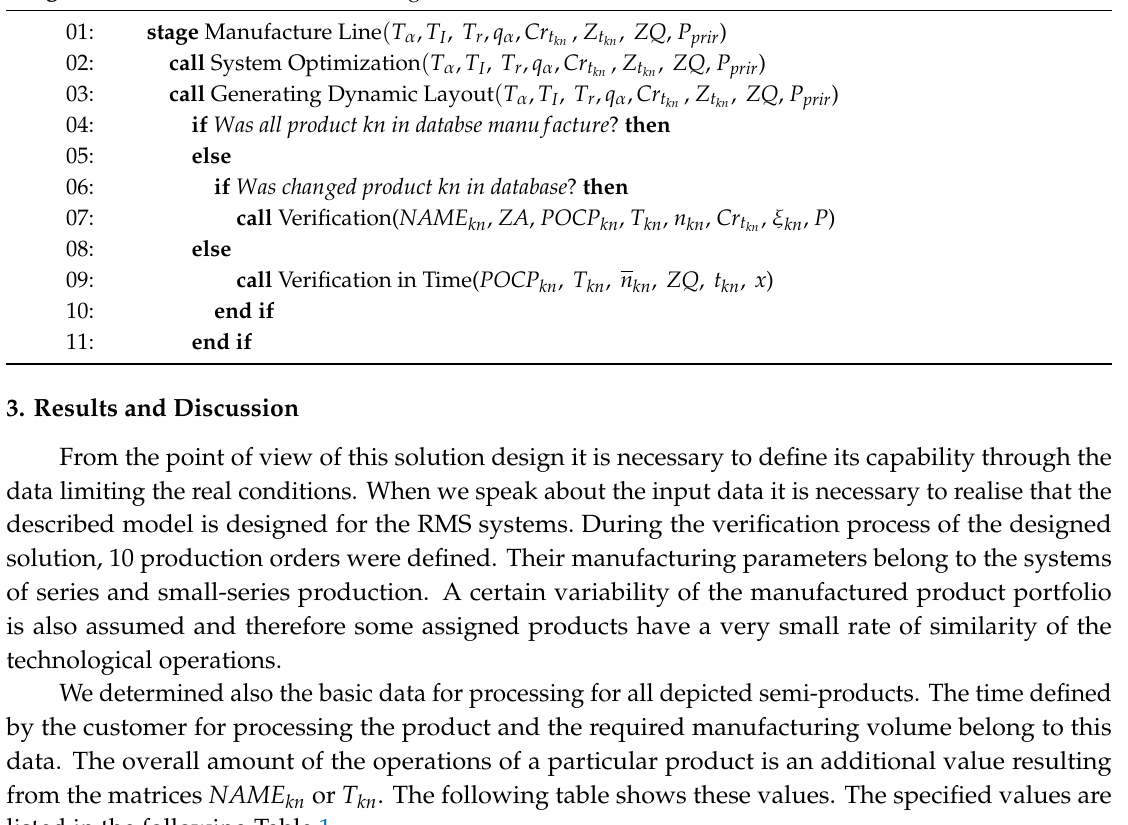
Algorithm 8 Manufacture Line